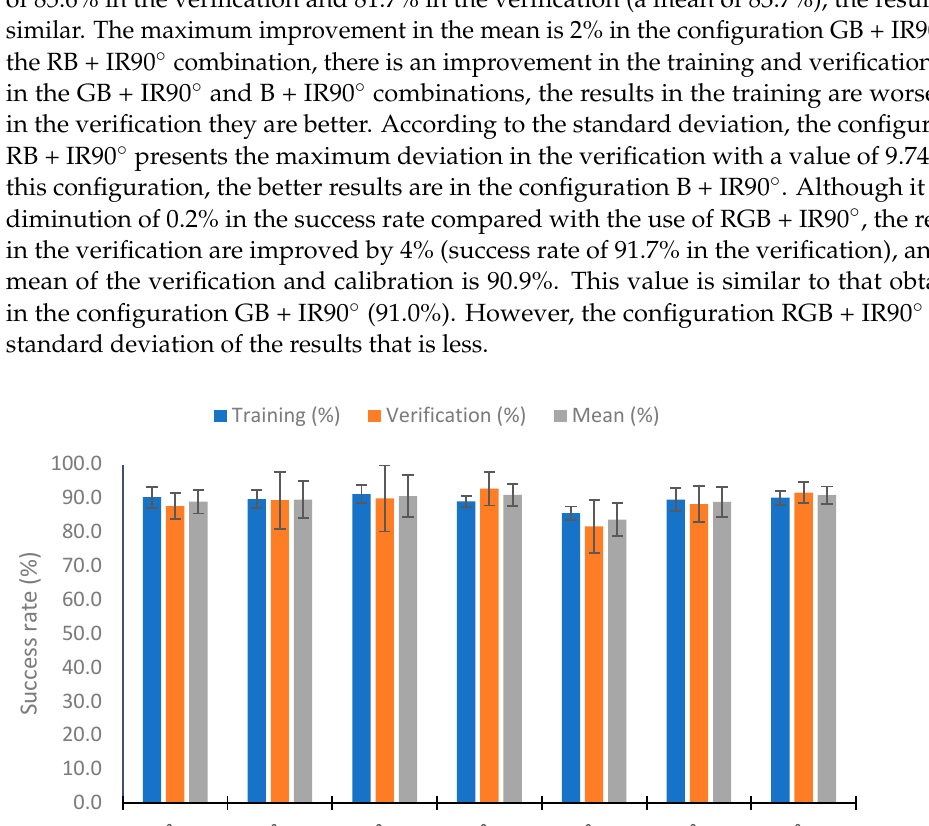
Figure 22. Success rate in the neural network with the data of the different RGB light and IR light at 90°.